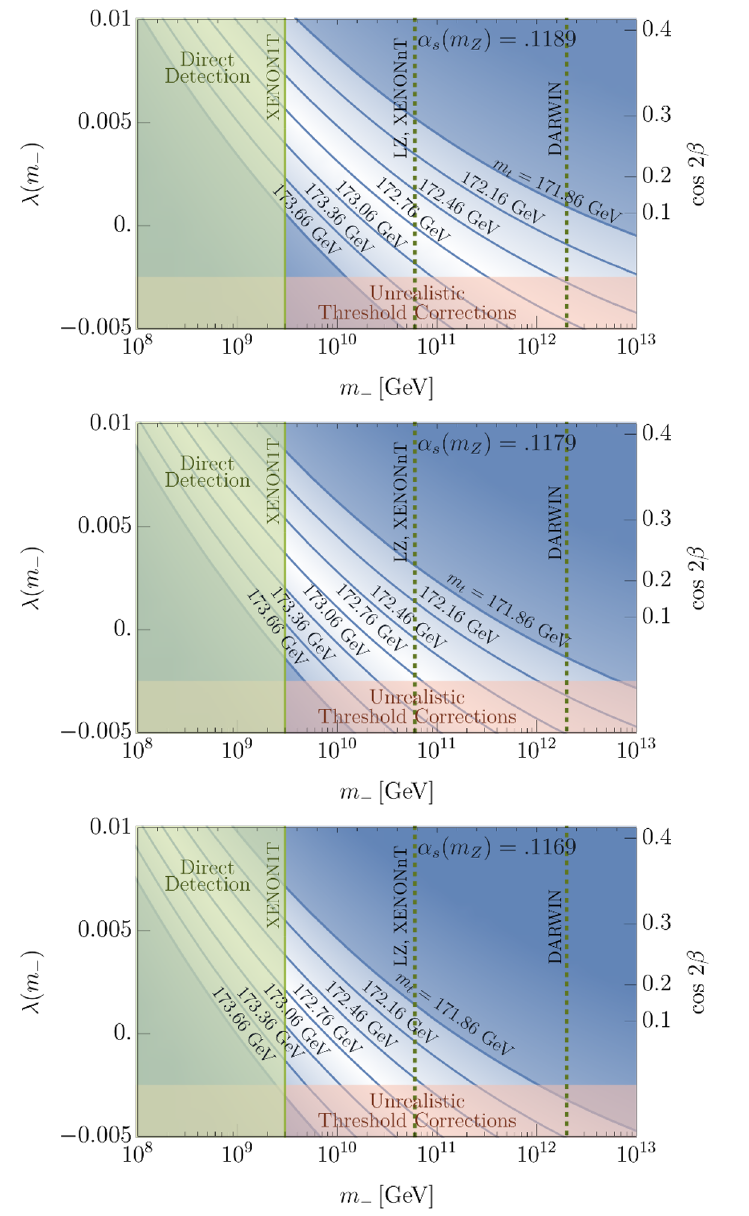
Figure 5 . Prediction for the top quark mass as a function of m − = min(m ˜q , m ˜¯u ) and the Higgs quartic coupling at m − . Contours of m t span 3 σ above and below the current central value for m t , (172 . 76 ± 0 . 30) GeV . The red shaded region requires unrealistically large negative supersymmetric threshold corrections to the quartic coupling. The green shaded region and the green dotted lines are as in figure 3. Values of m t are experimentally disfavored in the dark blue